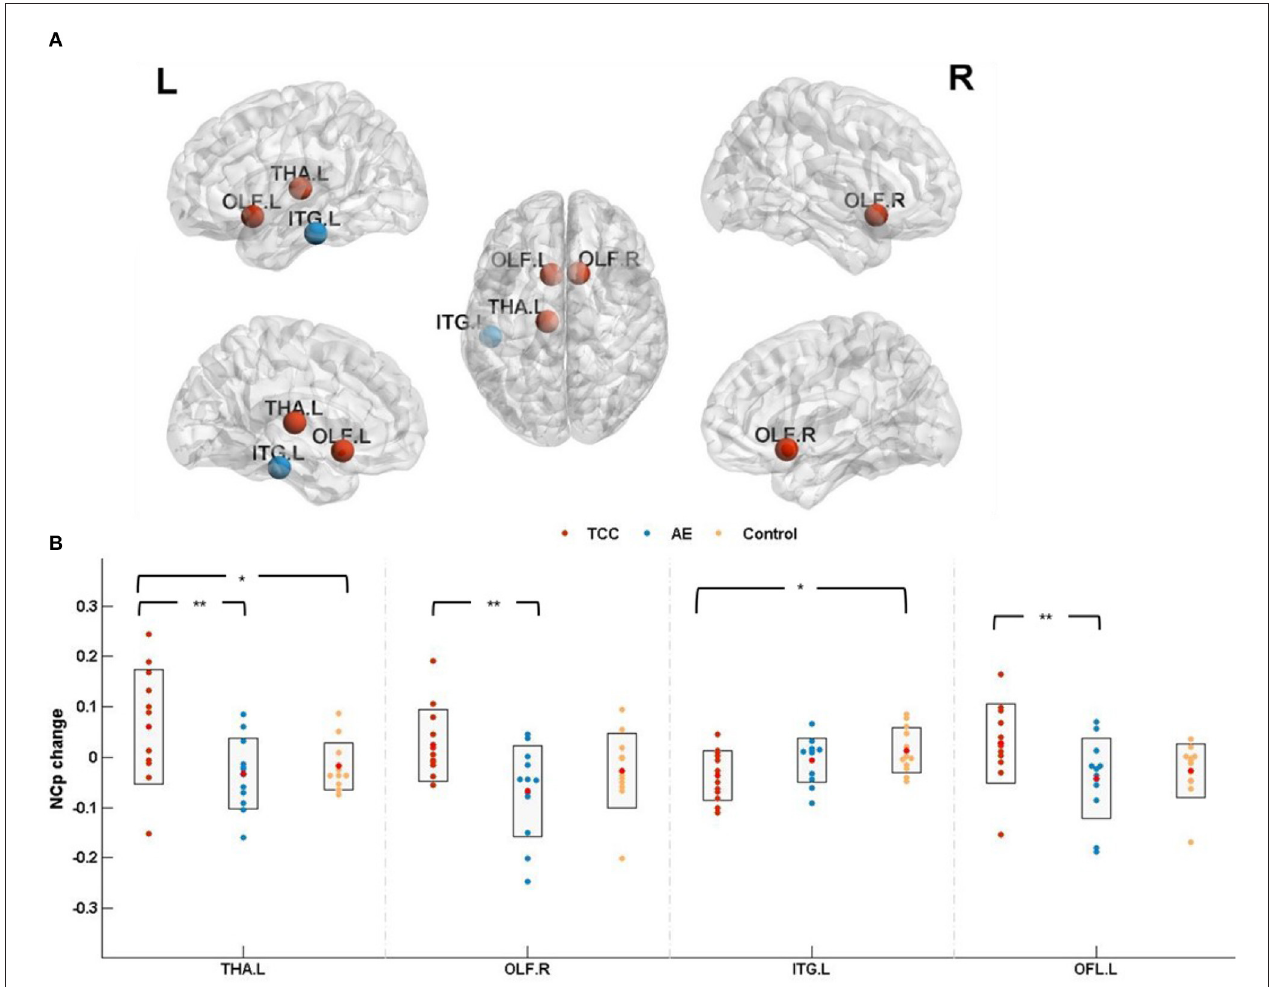
FIGURE 3 | Nodal clustering coefficient results. (A) The results of nodal clustering coefficient changes are presented on axial slices of the gray matter templates (MNI), Bonferroni-corrected. (B) The results of post-hoc statistical analysis of NC p changes (post minus pre). + indicates p < 0.06 (marginal significance), * p < 0.05, ** p < 0.01. THA.L, left thalamus; OLF.R, right olfactory cortex; ITG.L, left inferior temporal gyrus; OFL.L, left olfactory cortex; NC p , nodal clustering